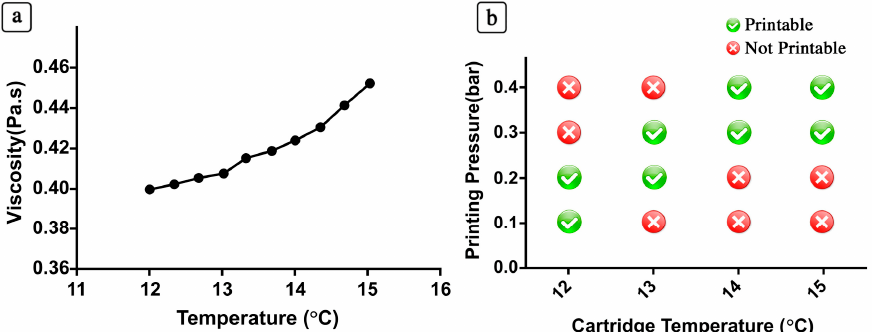
Figure 3. Viscosity and 3D printing parameters of the PIC hydrogels for a range of temperatures. In ( a ) the effect of temperature over the viscosity of a 5 mg/mL PIC solution is shown while in ( b ) the printability of PIC solution and the dependence of printing pressure on cartridge temperature are reported.